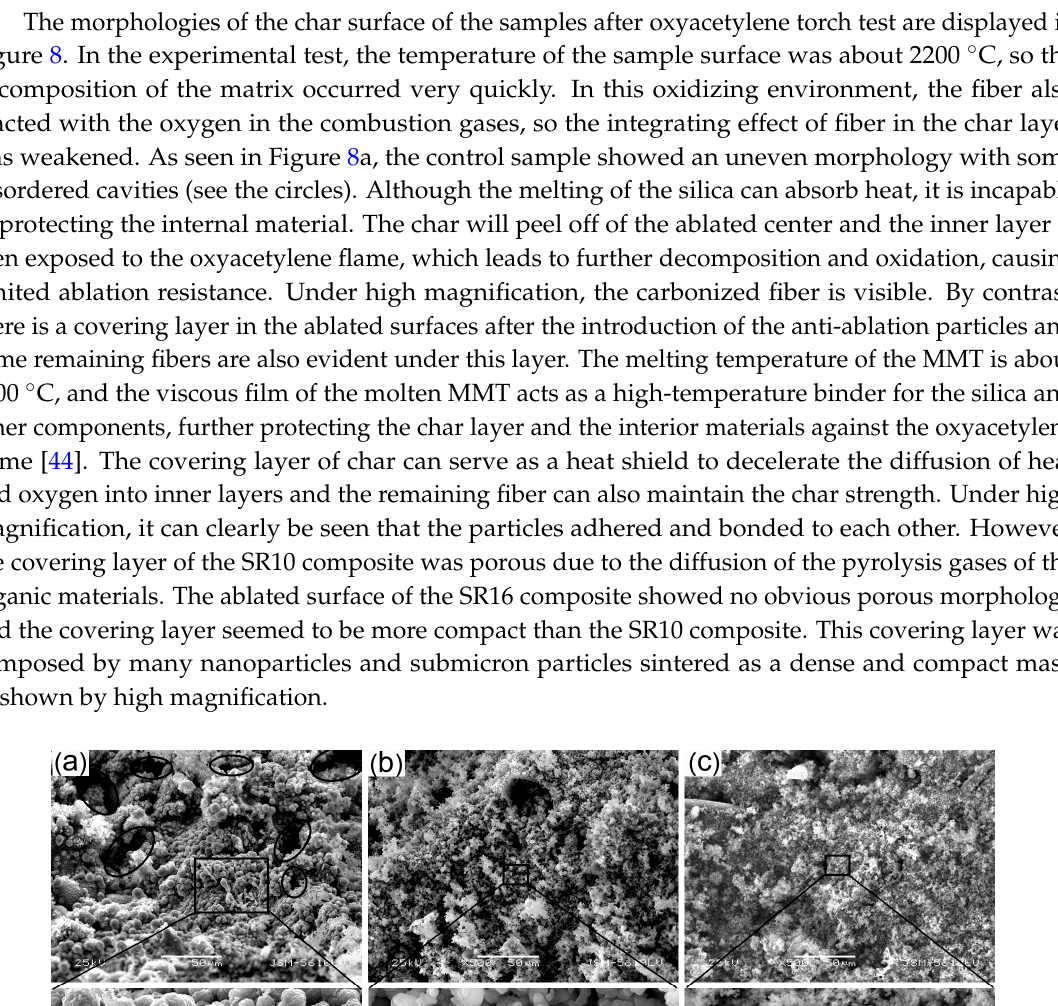
Figure 7. Photographs of ablated SR composites: ( a ) SR00; ( b ) SR10 and ( c ) SR16.